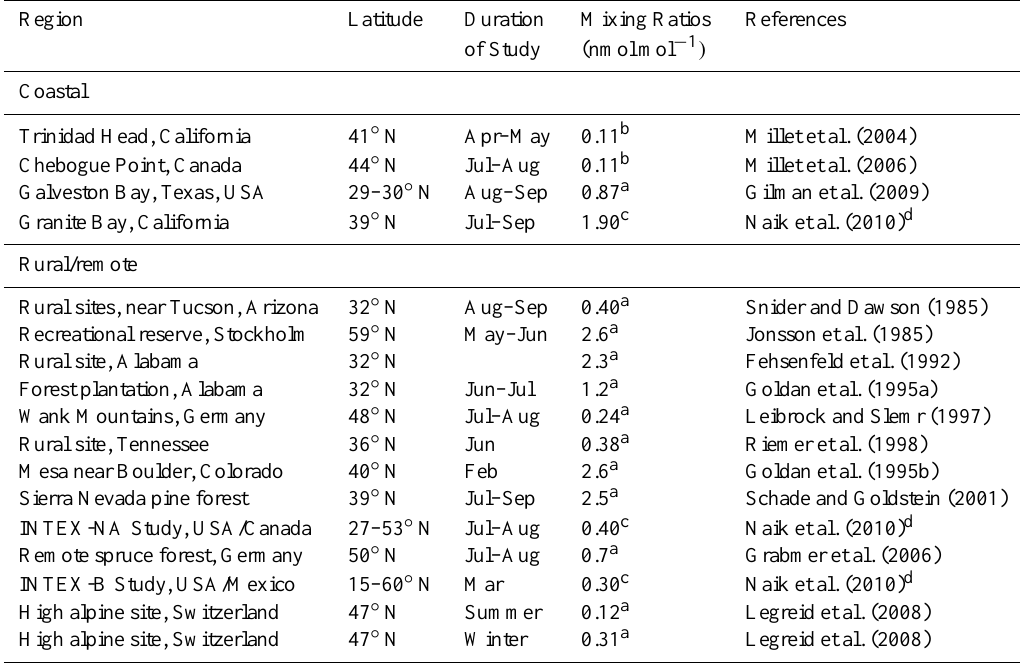
Table 2a. Mixing ratios of ethanol in the continental boundary layer.